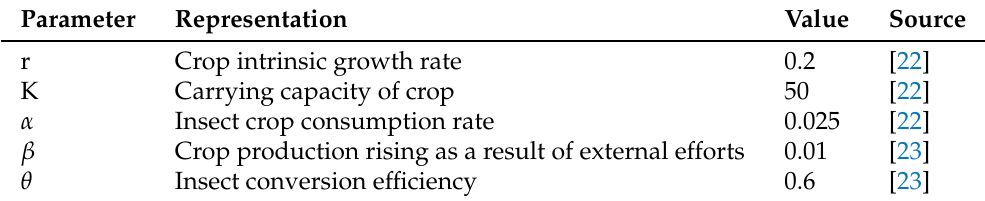
Table 1. Parameter setting for the numerical simulation of model